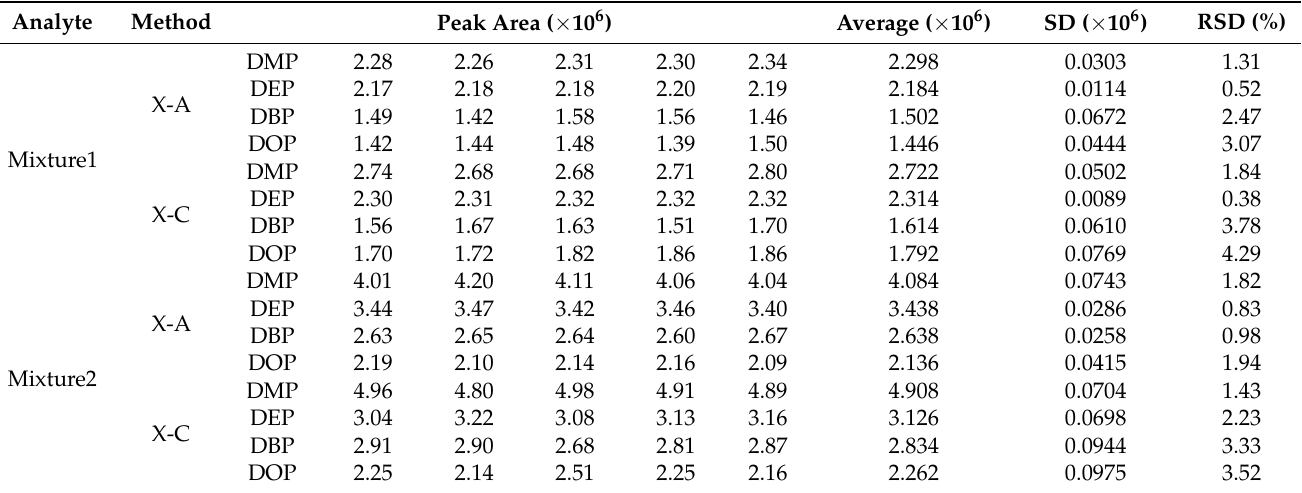
Table 8. Results of SPE of four kinds of PAEs.